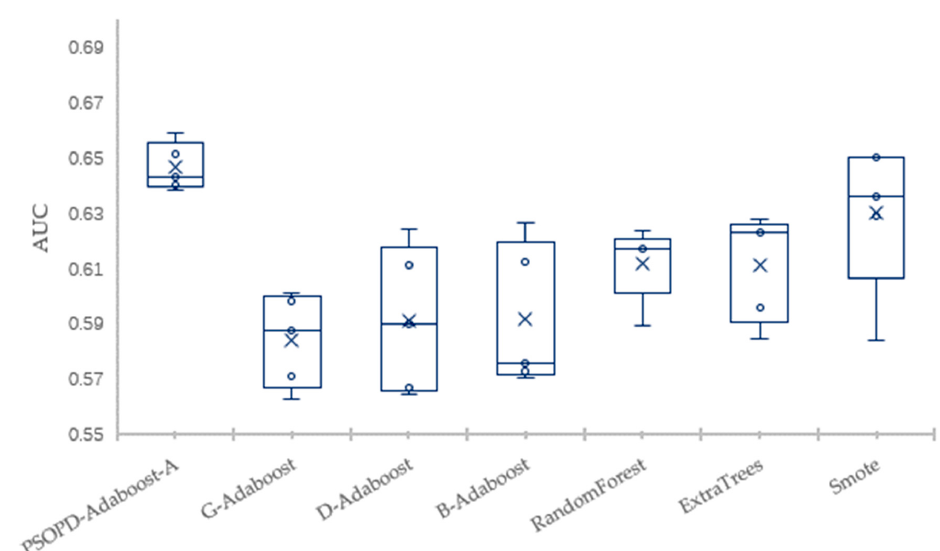
Figure 16. Comparison of AUC on the PC5 Dataset.